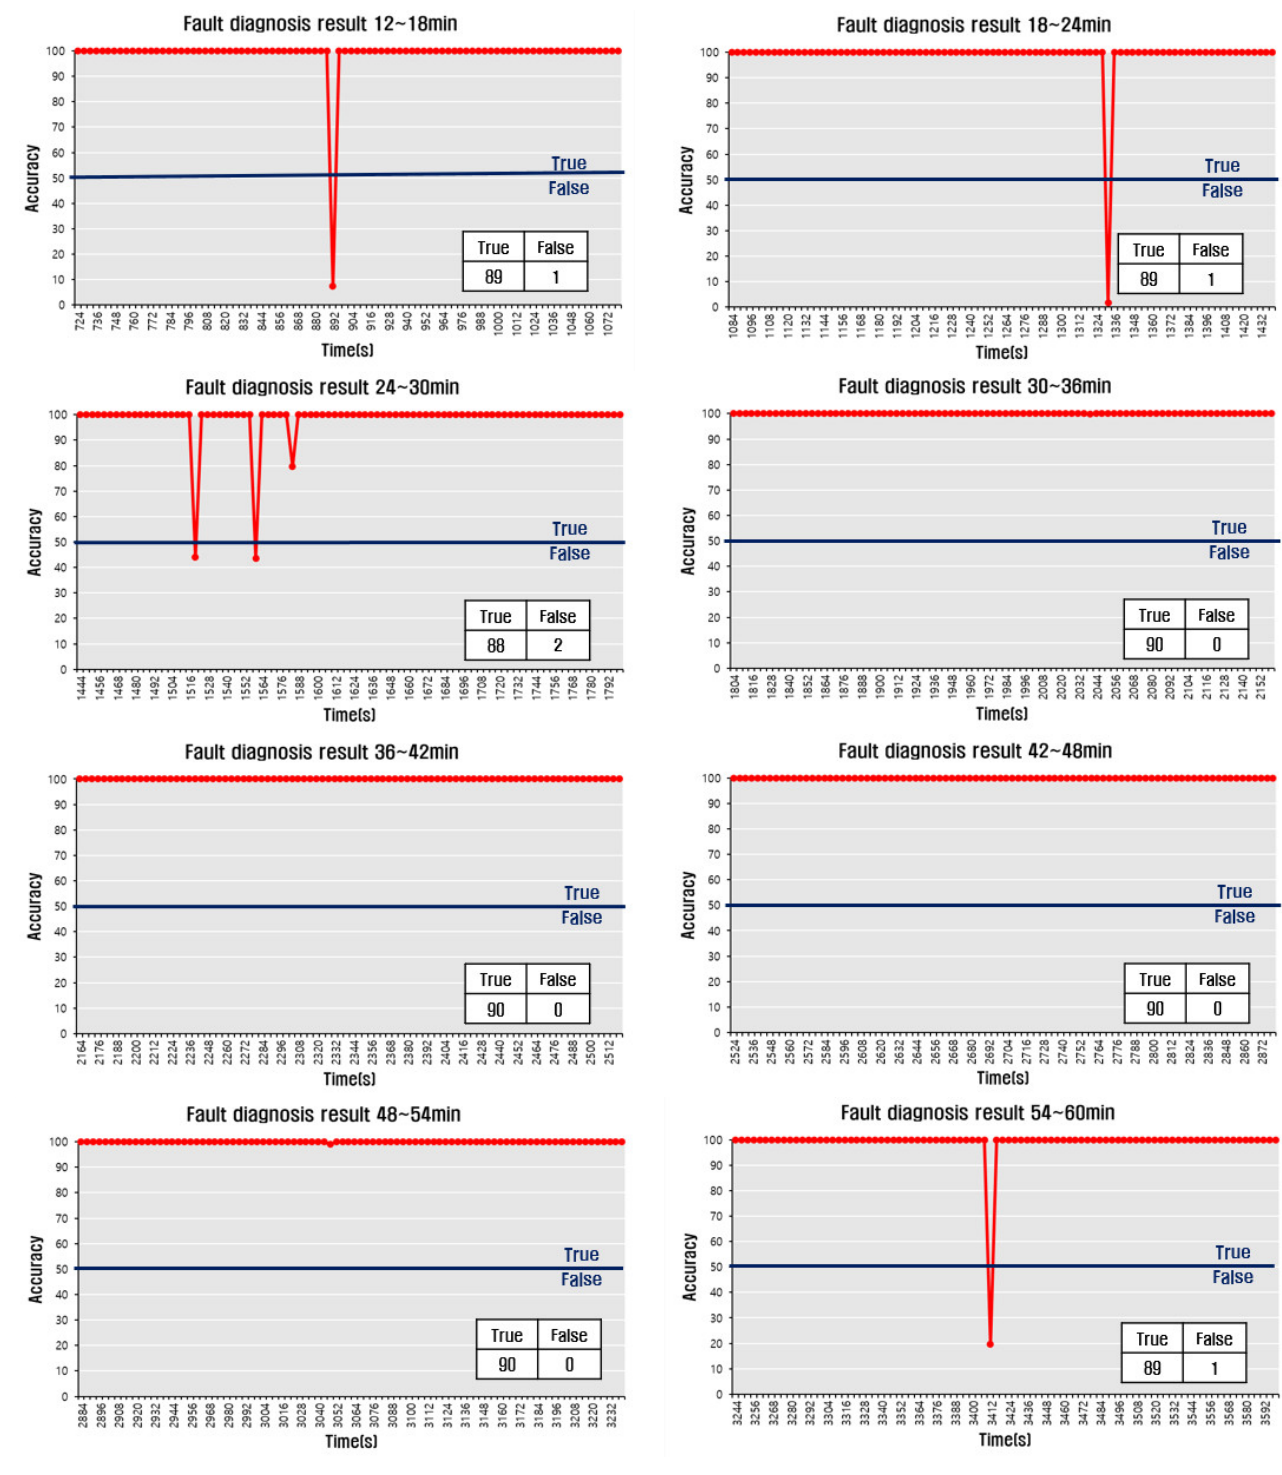
Figure 15. Test result with fault sound for 0~60 min.